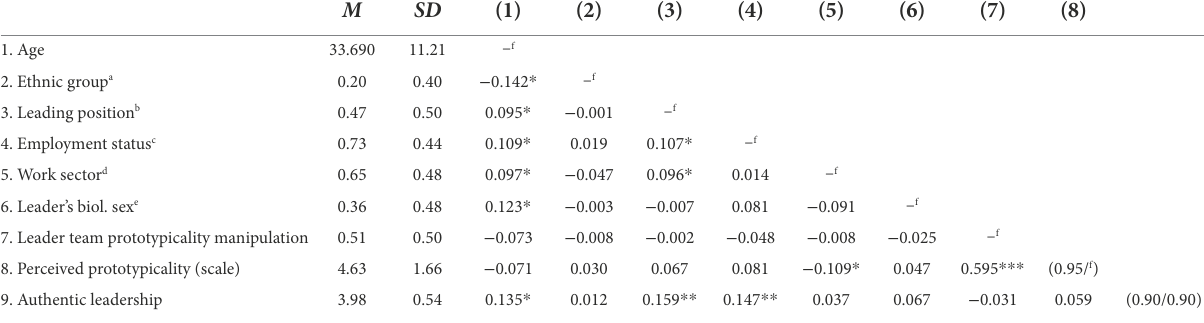
TABLE 3 Study 1: Means, standard deviations, intercorrelations, and reliabilities.